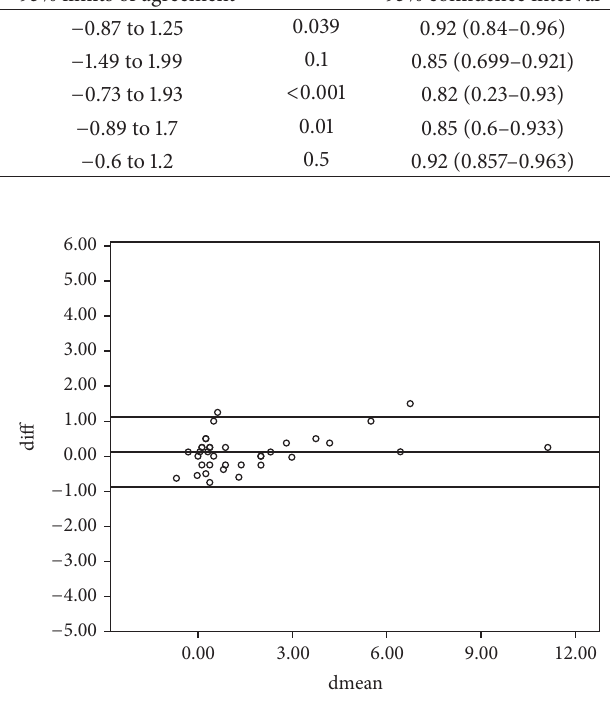
Figure 3: Bland-Altman plots comparing refractive measurements between retinoscopy and subjective refraction (spherical equiva- lent).